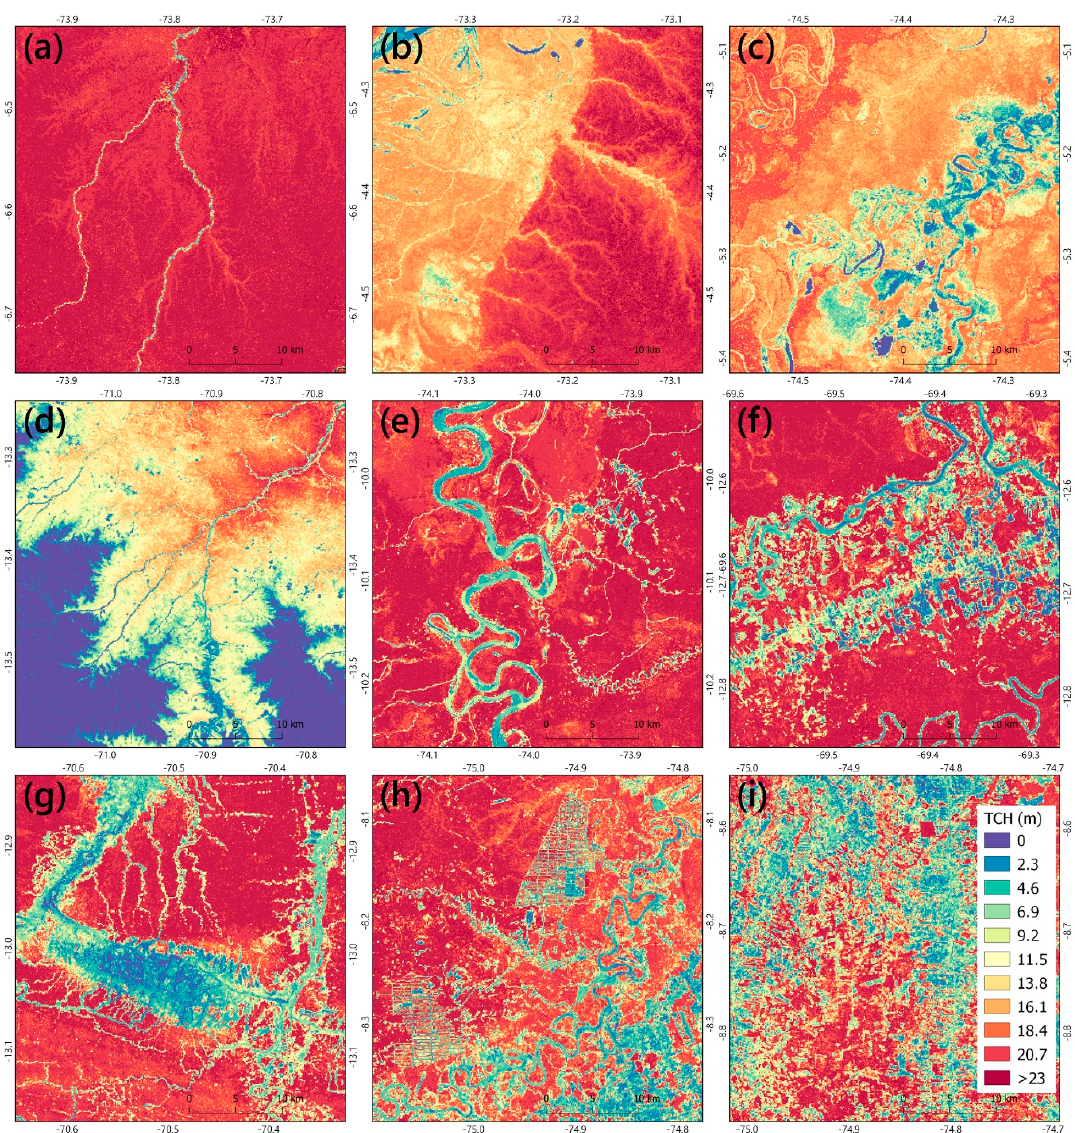
Figure 7. Subsets with di ff erent TCH distribution, with locations shown in Figure 6: ( a ) Intact forest in Loreto; ( b ) transition between flooded and terra firme forest in Loreto; ( c ) swamp forest in Loreto; ( d ) Andean tree line in Cusco; ( e ) logging roads and deforestation in Ucayali; ( f ) deforestation near Puerto Maldonado in Madre de Dios; ( g ) gold mining in Madre de Dios; ( h ) oil palm plantations and agriculture near Pucallpa in Ucayali; and ( i ) intense deforestation south of Pucallpa in Ucayali.